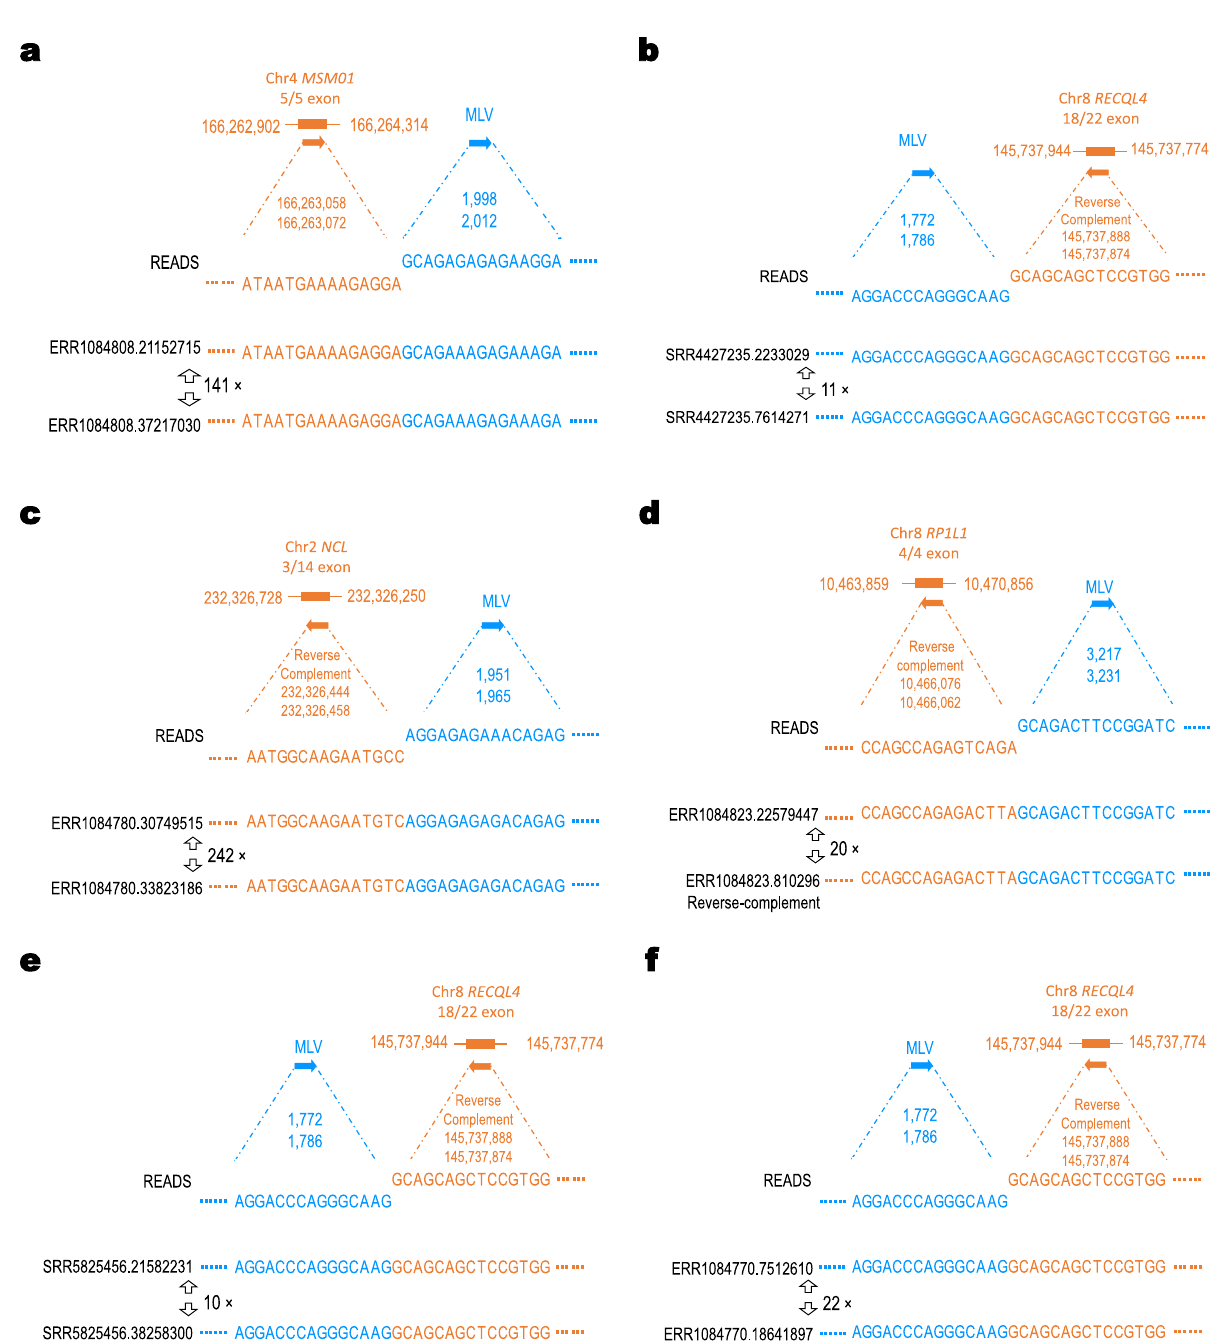
Fig. 4 Chimeric sequence reads containing both viral (blue) and human (orange) genome sequences were identi fi ed from PDX RNA-Seq reads for six tumor types, indicating the integration of murine viral genome. The chromosome, the gene name and the exon within which the integration site located is also provided. a Breast Cancer. Integration site is on chromosome 4, within the fi fth exon of the MSM01 gene which has fi ve exons. b GBM. Integration site is on chromosome 8, within the 18th exon of the RECQL4 gene which has 22 exons. c Lung Cancer. d Ovarian Cancer. e Bladder Cancer. f Colon Cancer. The genomic position and the orientation from human and virus genome are marked. The depth of coverage is labeled between reads. The detailed information is provided in Supplementary Data